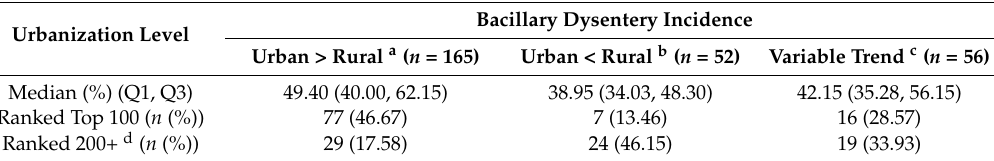
Table 1. Urbanization level and urban-rural incidence